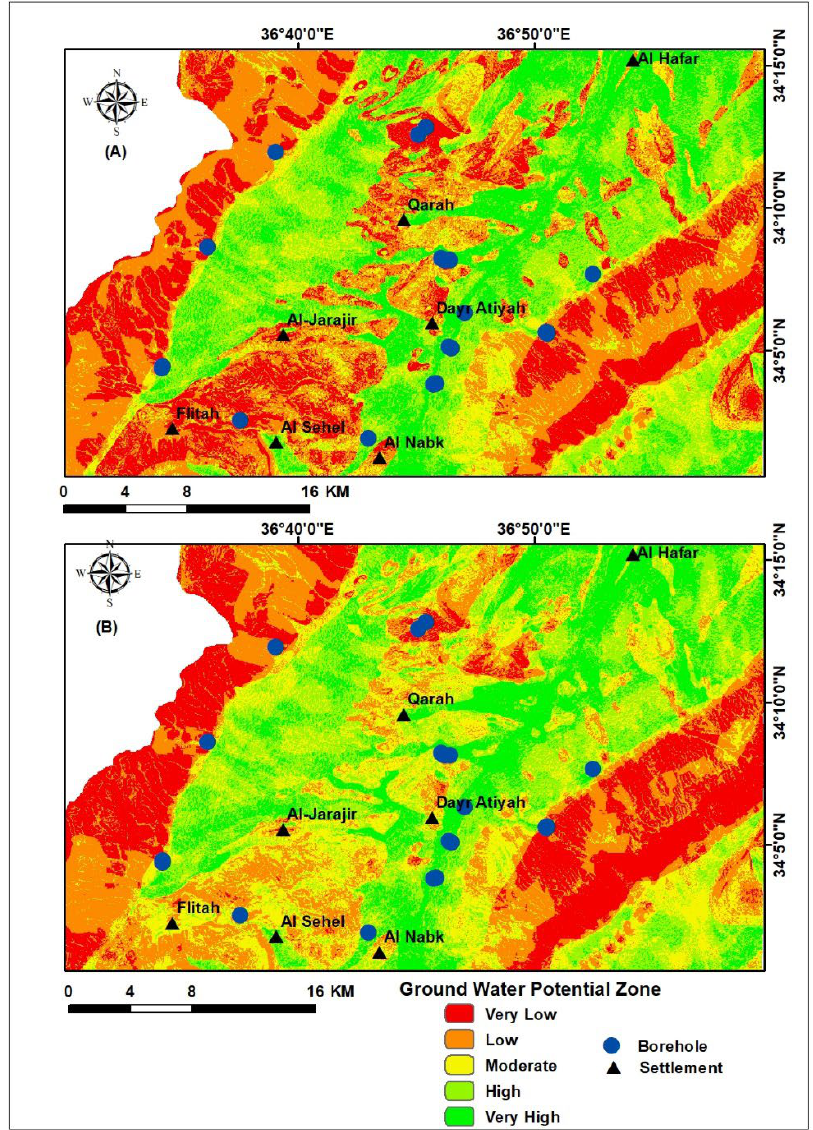
Figure 7. Groundwater Potential Zone of ( A ) AHP and ( B ) MIF maps.